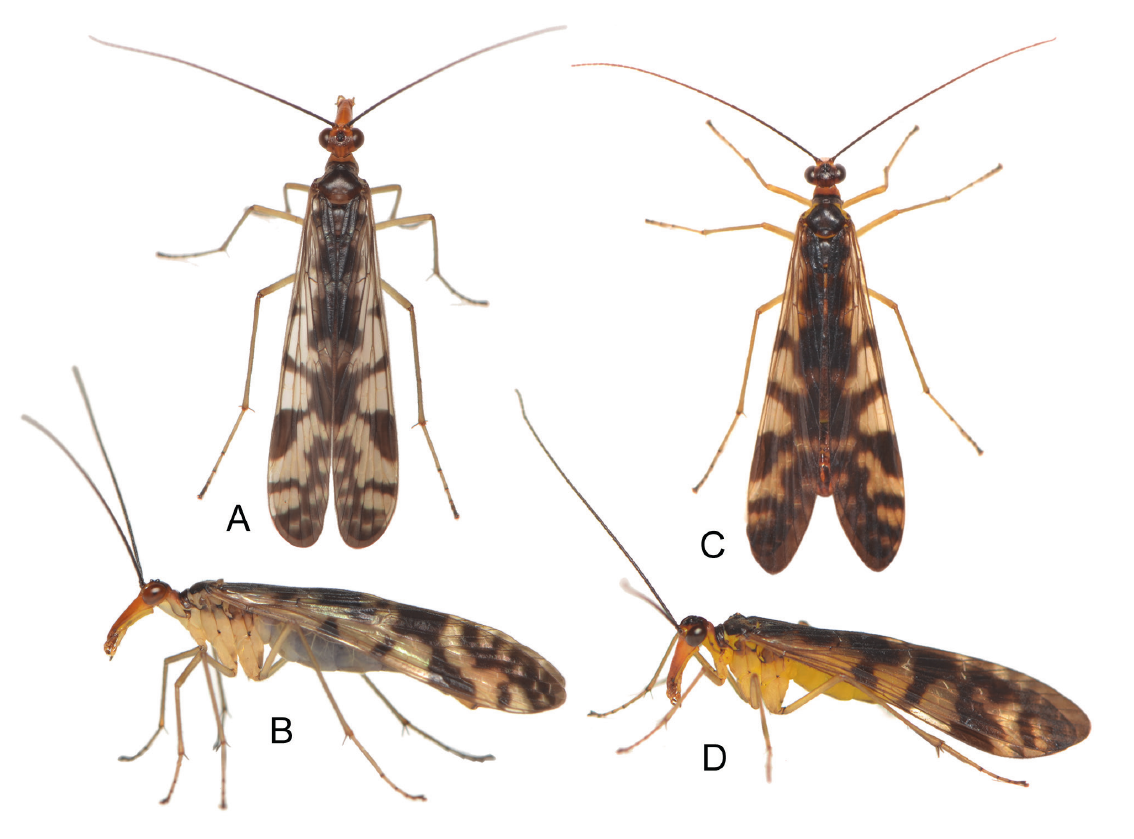
Fig. 4. Habitus of the Panorpa wormaldi group. A – B . P. gressitti Byers, 1970, ♂, dorsal and left-lateral views, respectively. C – D . P. zhuohengi sp. nov., holotype, ♂ (DALU) dorsal and left-lateral views,